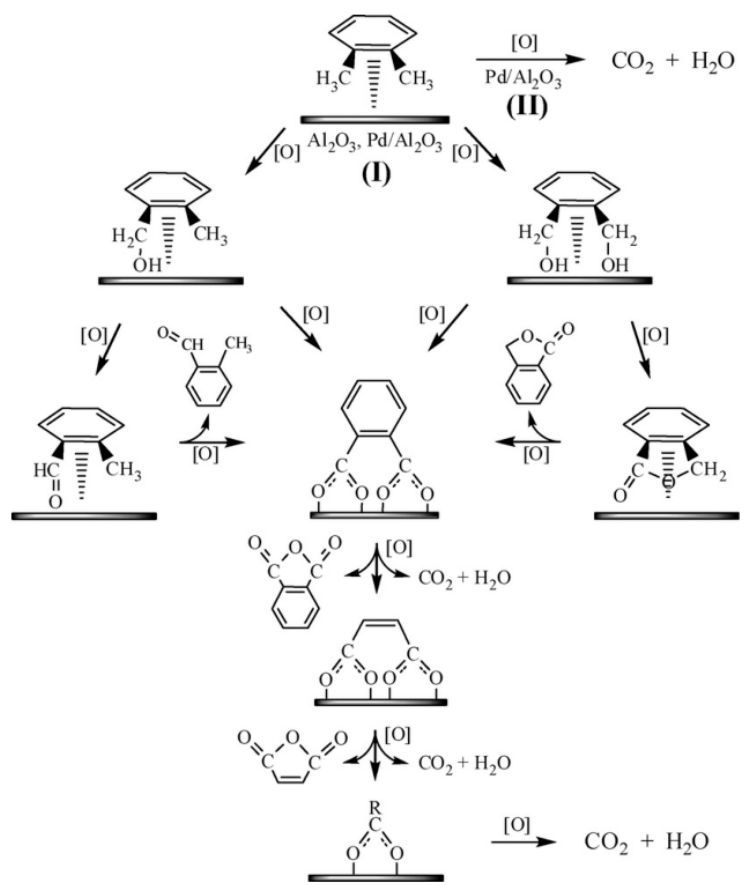
Figure 7. Reaction path diagram for the catalytic oxidation of o-xylene over Pd/Al 2 O 3 catalyst [145]. Table 5. Noble metal catalysts for catalytic oxidation of VOCs.